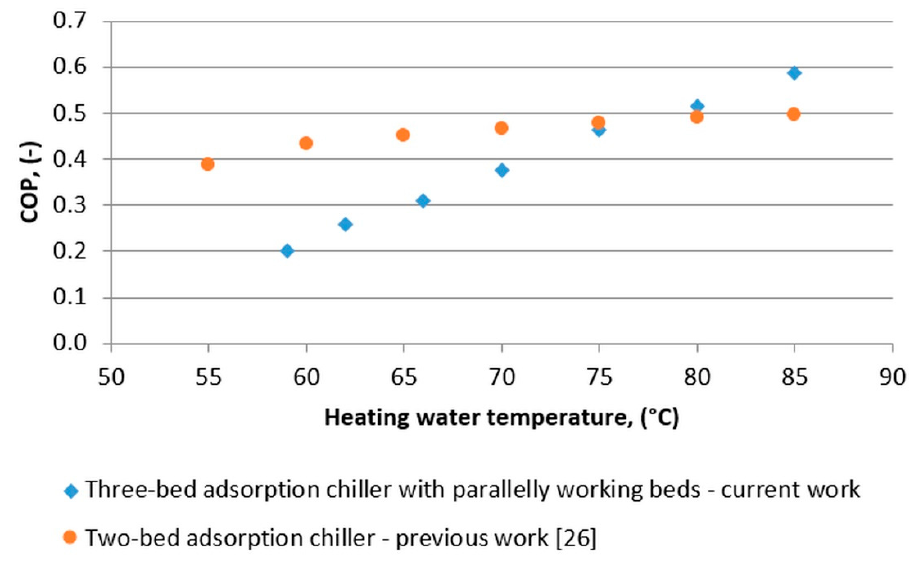
Figure 3. The influence of the heating water temperature on the coefficient of performance (COP).